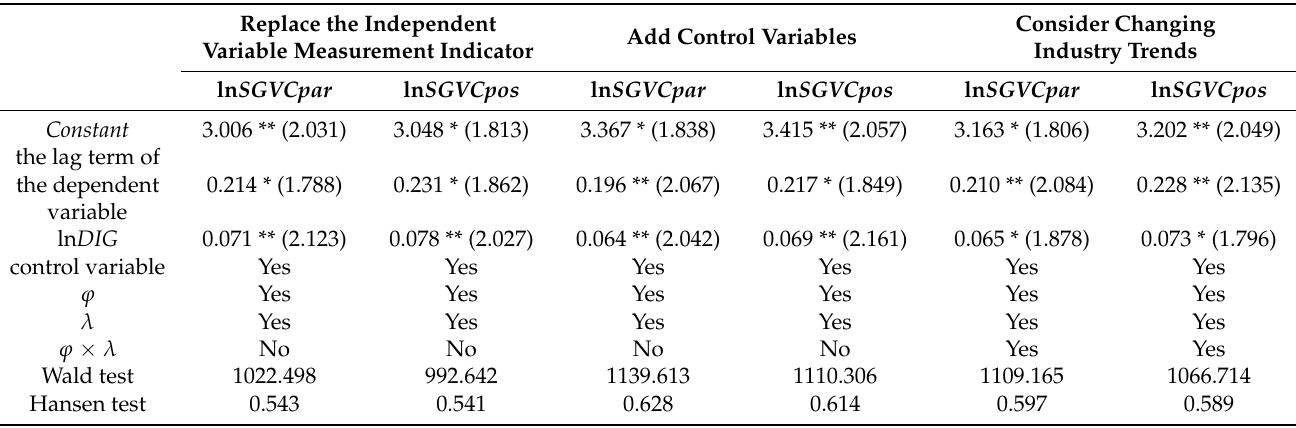
Table 3. Results of robustness test